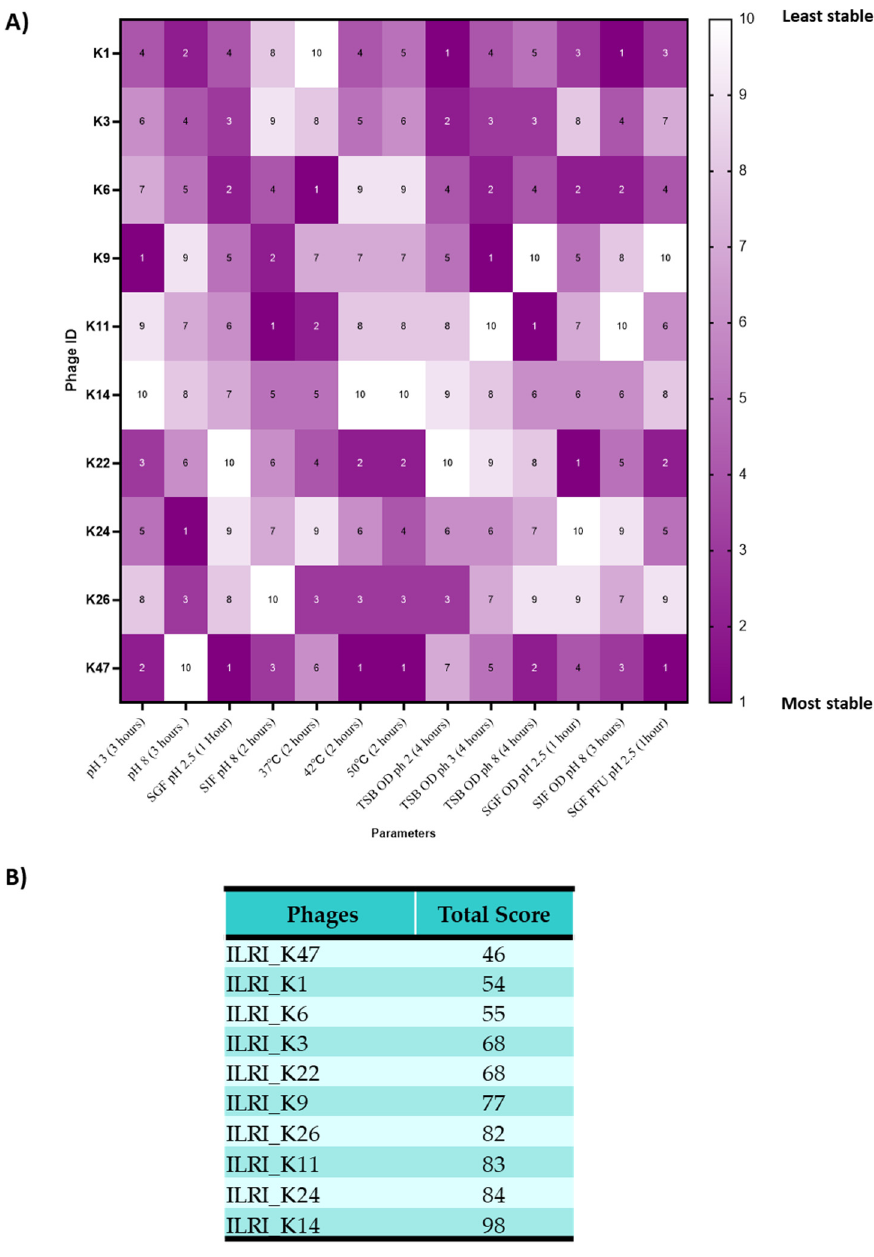
Figure 9. Phage stability scoring system. ( A ) The heatmap showing the ranking of the 10 S . Enteritidis phages based on the stability of 13 parameters, excluding water. Only the values at the end of the experiment were used for all these parameters. Deep purple indicates “most stable”, while white indicates “less stable”. All phages were ranked from the most stable (value of 1) to the least stable (value of 10) within a given parameter. ( B ) A table showing the ranking and scoring system for the phages. The total stability score was computed by adding individual scores for each parameter. The lowest value indicates the most stable phage.